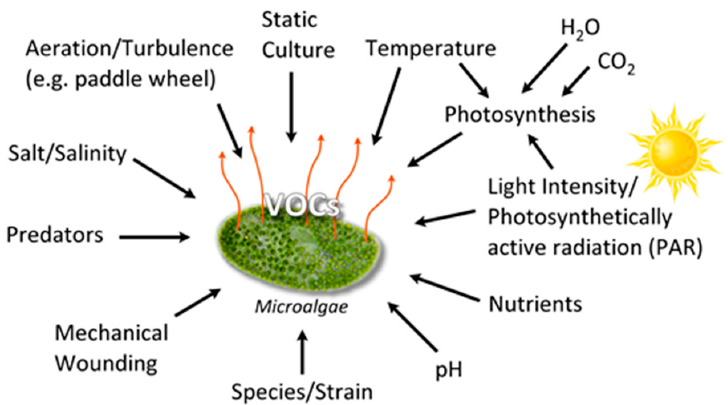
Figure 2. Factors influencing in vivo microalgae VOCs emission.